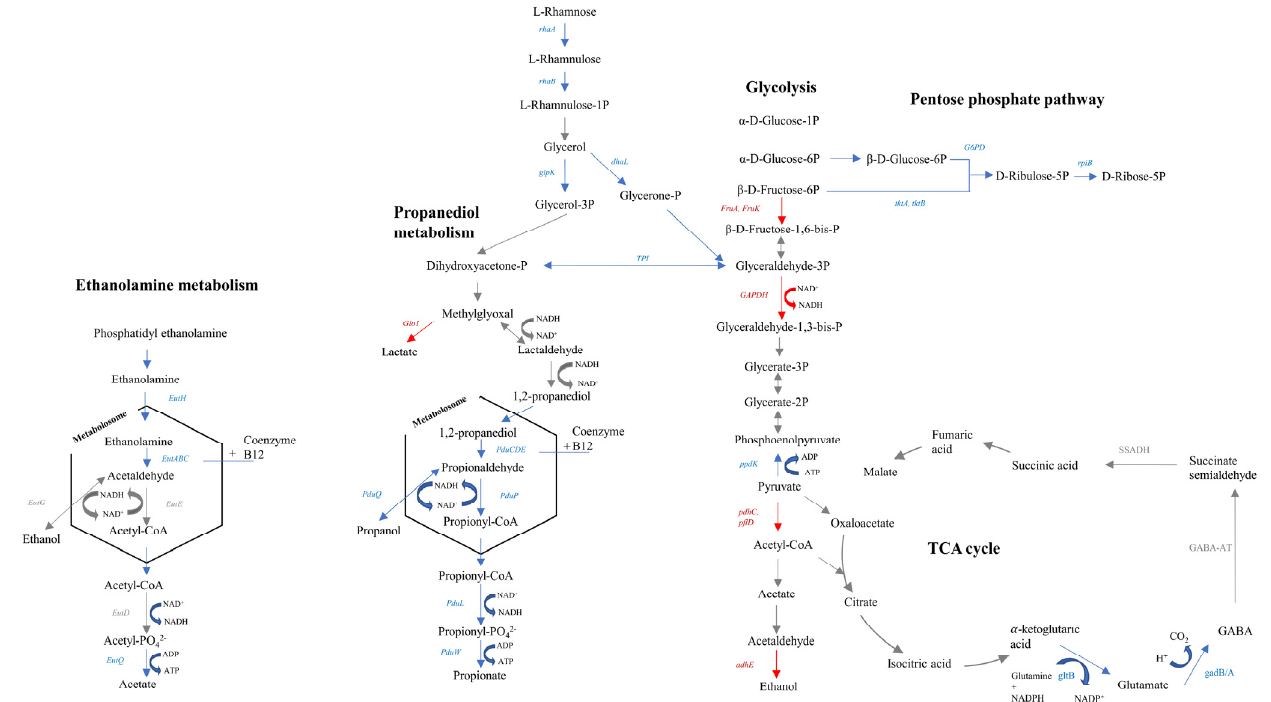
Figure 3. Predicted carbon flux in L. monocytogenes CTC1034 and EGDe when exposed to lactate. Blue, red, and grey arrows and text indicate genes that were upregulated, downregulated, or were not differentially expressed, respectively. Genes and proteins: EutH , ethanolamine transporter; EutA , ethanolamine transporter protein EutA; EutB , ethanolamine ammonia-lyase large subunit; EutC , ethanolamine ammonia-lyase small subunit; EutG , alcohol dehydrogenase; EutE , aldehyde dehydrogenase; EutD , phosphotransacetylase; EutQ , ethanolamine utilization protein EutQ; Glo1 , lactoylglutathione lyase; PduC , propanediol dehydratase large subunit; PduD , propanediol dehydratase medium subunit; PduE , propanediol dehydratase small subunit; PduP , propionaldehyde dehydrogenase; PduQ , 1-propanol dehydrogenase; PduL , phosphate propanoyltransferase; PduW , propionate kinase; TPI , triosephosphate isomerase; FruA , fructose PTS system EIIBC; FruK , 1-phosphofructokinase; GAPDH , glyceraldehyde 3-phosphate dehydrogenase; ppdK , pyruvate orthophosphate dikinase; pdhC , pyruvate dehydrogenase E2 component; pflD , formate C-acetyltransferase; adhE , acetaldehyde dehydrogenase/alcohol dehydrogenase; tktA , tktB , transkelotase; G6PD , glucose-6-phosphate 1-dehydrogenase; RpiB , ribose 5-phosphate isomerase B; DhaL , phosphoenolpyruvate-glycerone phosphotransferase subunit DhaL; GlpK , glycerol kinase; RhaB , rhamnulokinase; RhaA , L-rhamnose isomerase; gltB , glutamate synthase; gadB/A , glutamate descarboxylase; GABA-AT , GABA aminotransferase; SSADH , succinate semialdehyde dehydrogenase